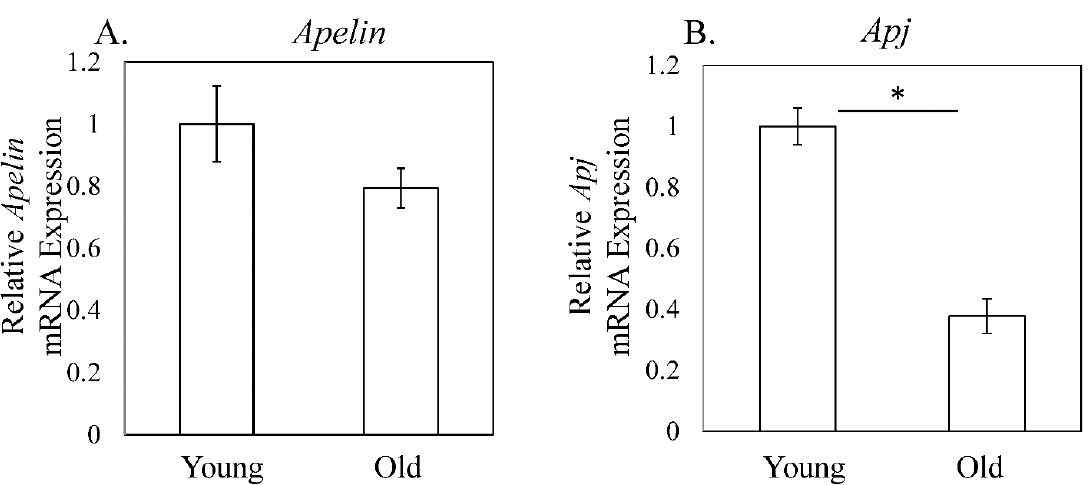
Figure 2. Relative expression of Apelin, and Apj mRNA in the quadriceps femoris. ( A ) Apelin and ( B ) APJ expression in young (3-month-old) and old (24-month-old) mice. There was no difference in Apelin mRNA expression between young and old mice (Figure 1A). Apj mRNA expression was significantly lower in old mice than in young mice ( p < 0.001, Figure 1B). Data are expressed as the mean ± standard deviation (SD). Asterisks indicate p < 0.05.